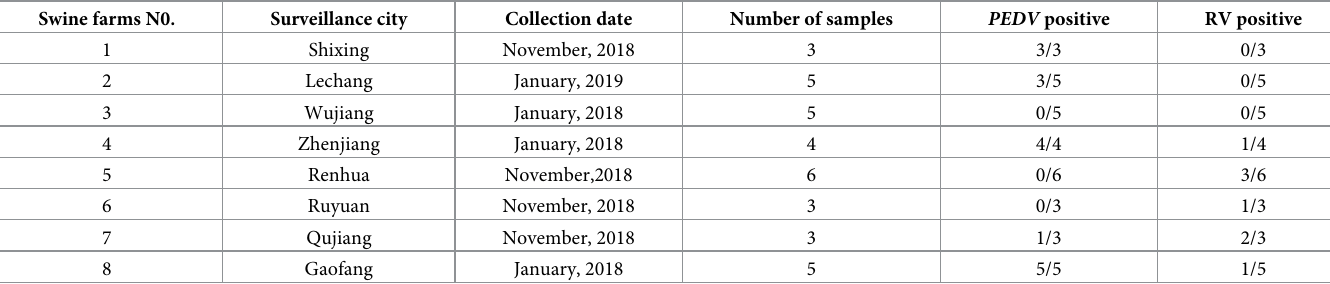
Table 1. Details of sample information in this study. Swine farms